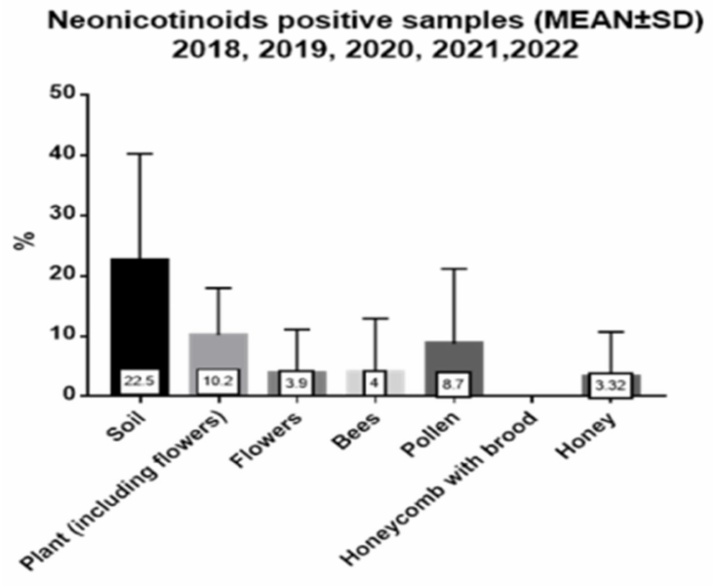
Figure 2. Percentage of NNI-positive